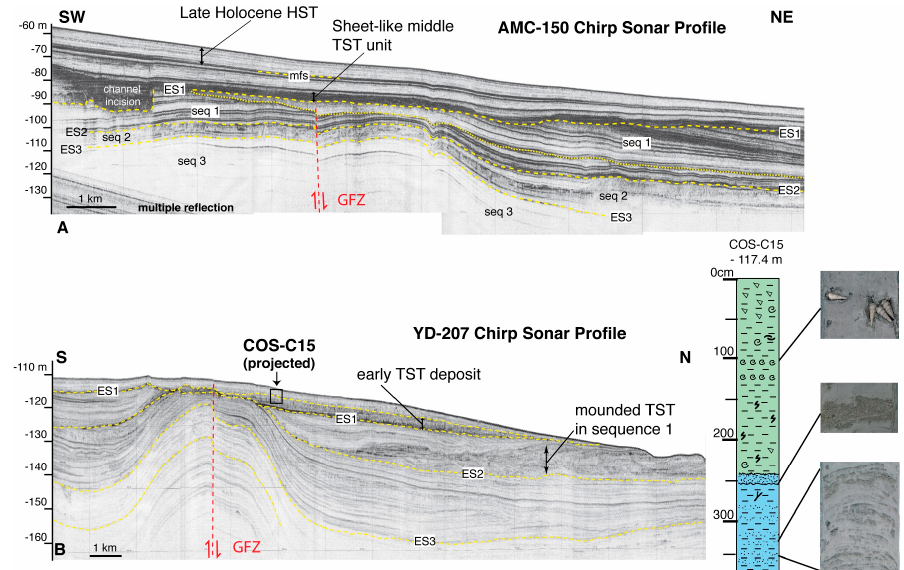
Figure 10. Seismic profiles (location in Figures 1 and 6) evidencing the absence of mounded TST deposits in shelf sectors shallower than − 90 m (( A ) modified from [51]), and the southward thinning/flattening of TSR deposits along the shelf edge (( B ) modified from [44]). AMC-150 seismic profile ( A ) shows an opaque TST unit that correlates landward with middle TST deposits, although directly overlaying ES1 unconformity (affected by channel incision along the south-eastern flank of the anticline). In YD-207 seismic profile ( B ), early TST deposits that correlate with TSR at north form a flat-tabular unit terminating against the flank of the anticline, by this marking their southward limit. A detail of the core that reached these deposits is shown (see Figures 6 and 7). Note the mounded-irregular TST unit at the base of sequence 1 (on top of ES2), interpreted as older equivalent of TSR mounded deposits.